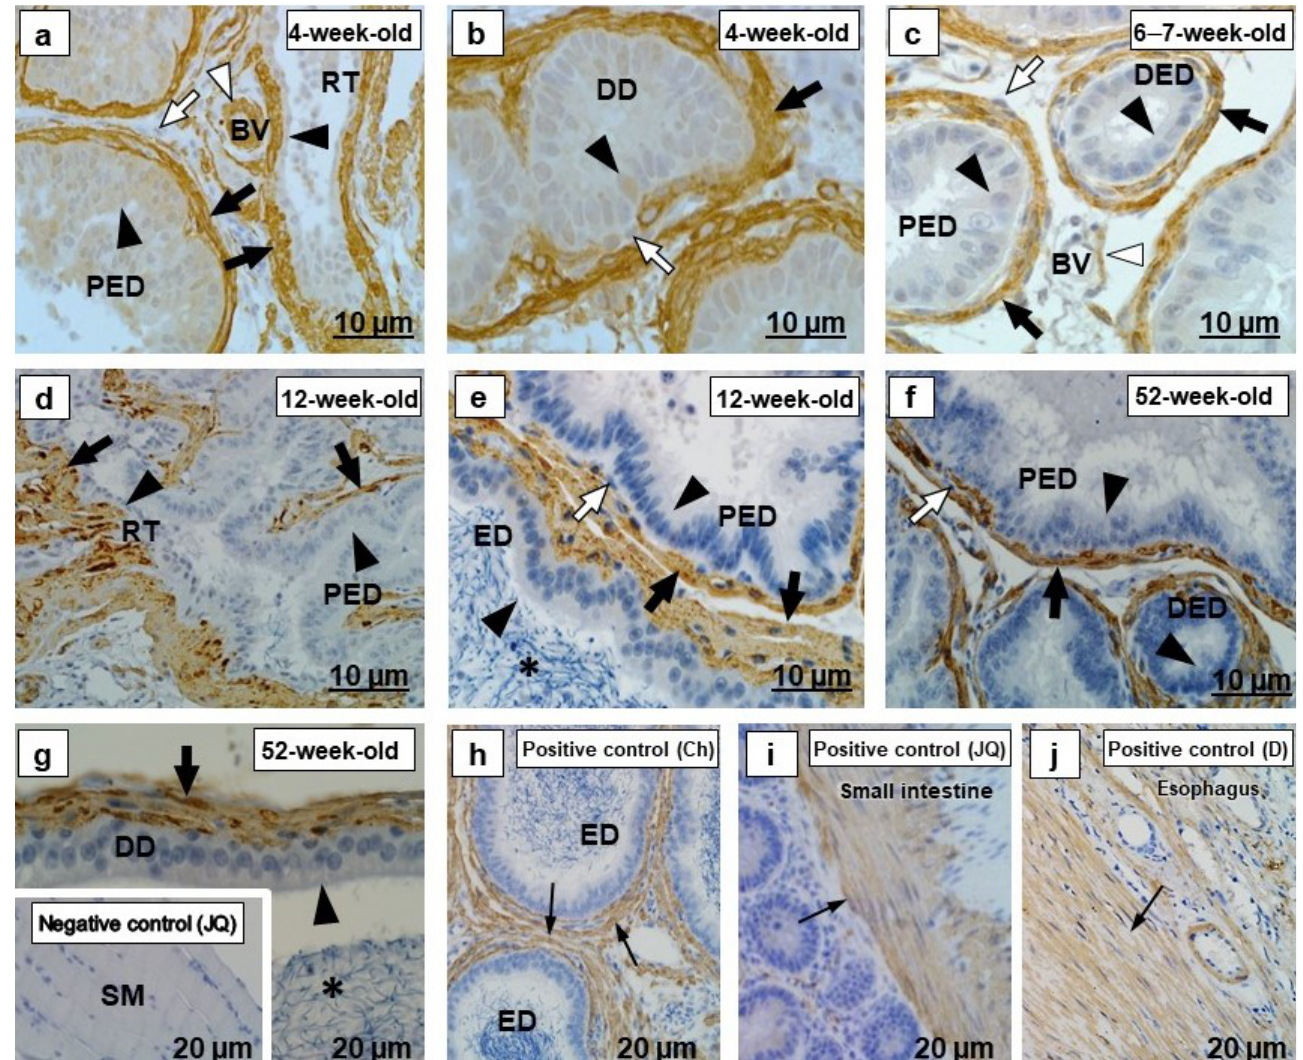
Figure 5. Alpha-smooth muscle actin immunolocalization in the testicular excurrent duct system of Japanese quails ( n = 7 per age group). ( a , b ) Weak immunostaining in the epithelia (black arrowheads) of the RT, PED and DD. ( a ) Strong immunostaining in the tunica media (white arrowhead) of interductal blood vessels. ( c – g ) Immunonegative epithelia (black arrowheads) of the RT, PED, DED, ED and DD. ( a – g ) Black arrows indicate strong immunostaining in the periductal smooth muscle layer. Immunonegative fibroblasts (white arrows). ( c ) Moderate immunostaining in the tunica media (white arrowhead) of interductal blood vessel. ( e , g ) Immunonegative spermatozoa (asterisks). Inset ( g ) Negative control: Striated muscle of an adult Japanese quail. ( h – j ) Positive controls: Thin black arrows indicate immunopositive labeling of smooth muscle cells in the epididymal duct of the chicken ( h ), small intestine of an adult Japanese quail ( i ) and esophagus of the dog ( j ). RT, Rete testis. PED, Proximal efferent duct. DED, Distal efferent duct. CD, Connecting duct. ED, Epididymal duct. DD, Ductus deferens. BV, Blood vessel. Ch, Chicken. D, Dog. JQ, Japanese